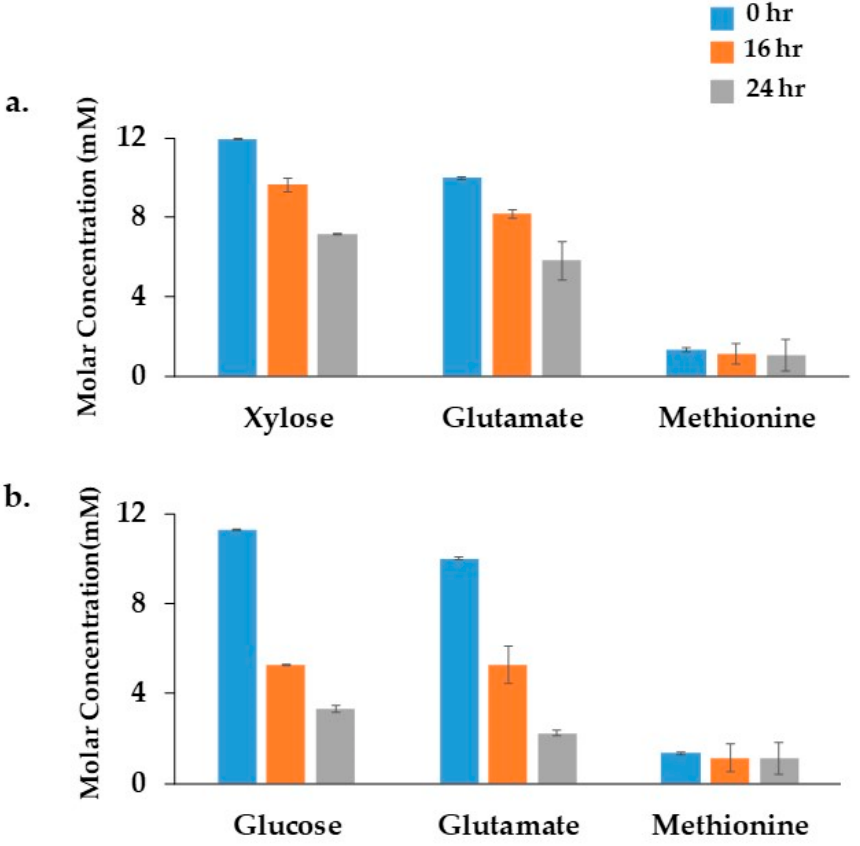
Figure 2. Identification of substrate consumption using 1 H NMR: The consumption of different XOM2 media components by Xanthomonas oryzae pv. oryzae BXO43 cells was confirmed using a 1 H NMR analysis. The x -axis represents the XOM2 media components with: ( a ) Xylose; and ( b ) Glucose as a carbon source. The y -axis indicates the molar concentration of each component in minimal media. The decrease in concentration of each component with a relevant standard error of the mean ( n = 3) shows the consumption of Glucose, Xylose, Glutamate and Methionine by the BXO43 cells. The BXO43 cells were harvested at three different time points, namely, 0, 16 and 24 h, as depicted by the blue, orange and grey bar in each graph.